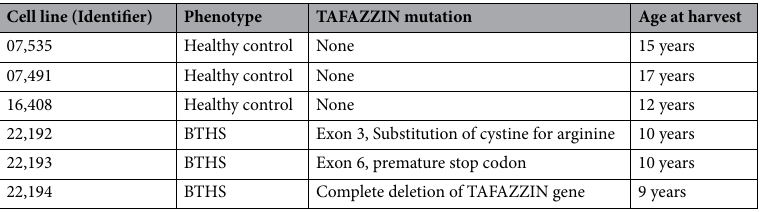
Table 1. Cell lines used in this